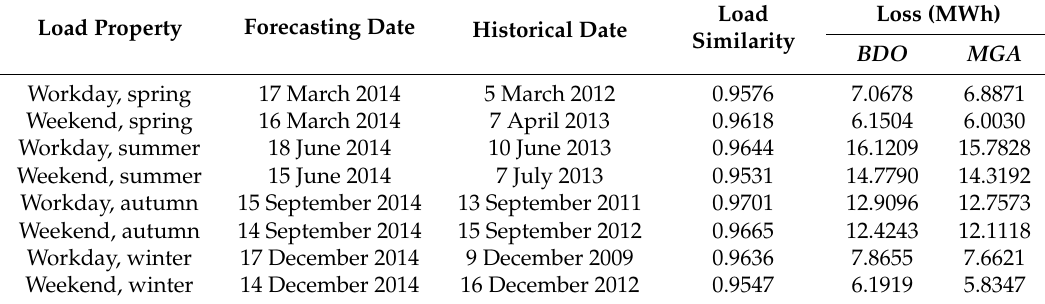
Table 7. Optimization results of typical